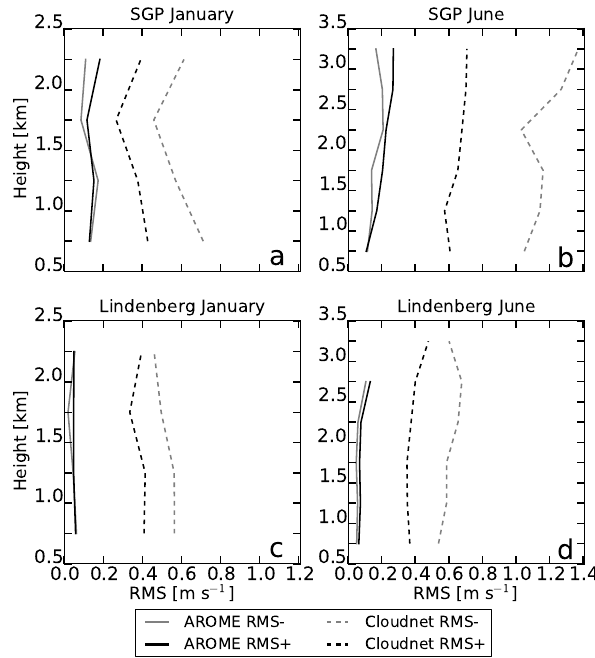
Fig. 7. Profiles of RMS-values calculated separately for negative and positive parts of the vertical velocity PDFs from AROME and the observations.